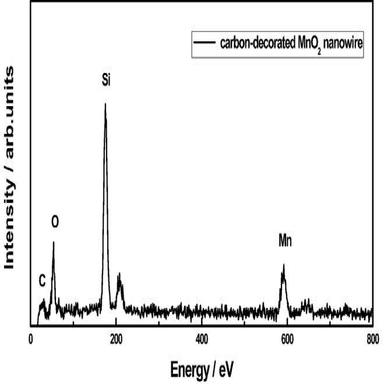
EDS analysis of MnO2 nanowires.